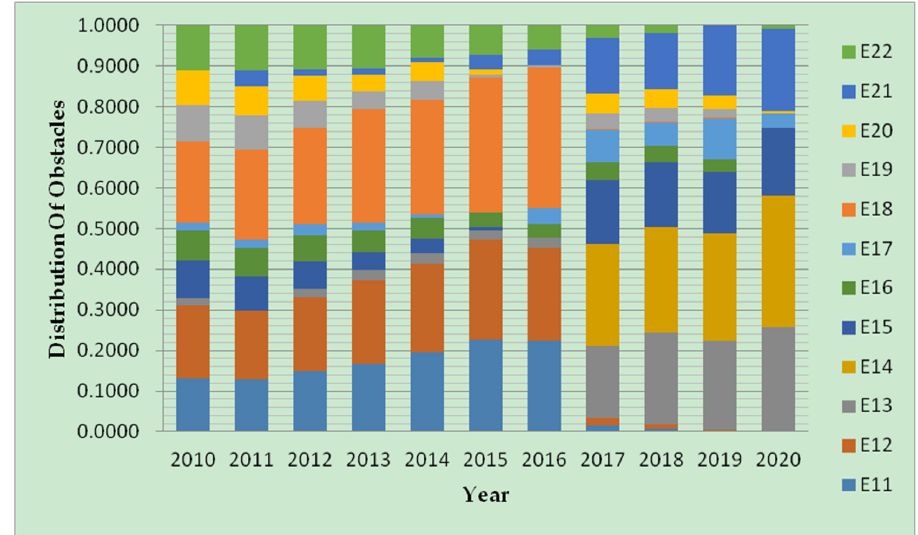
Figure 7. Distribution of obstacles to improving cultivated land-use benefits in Suizhou City.